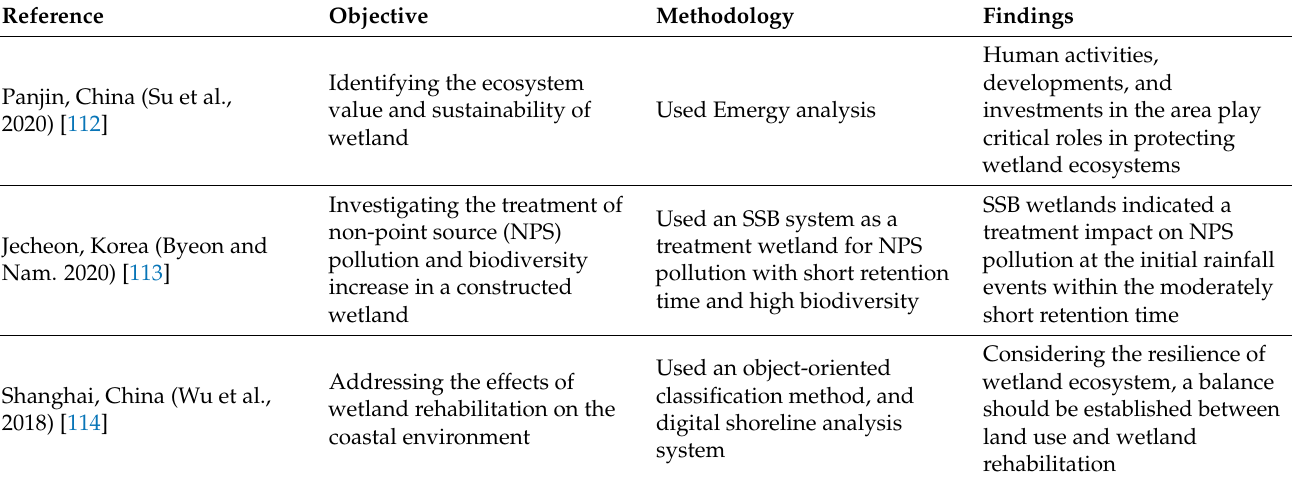
Table 4. Urban wetlands and urban